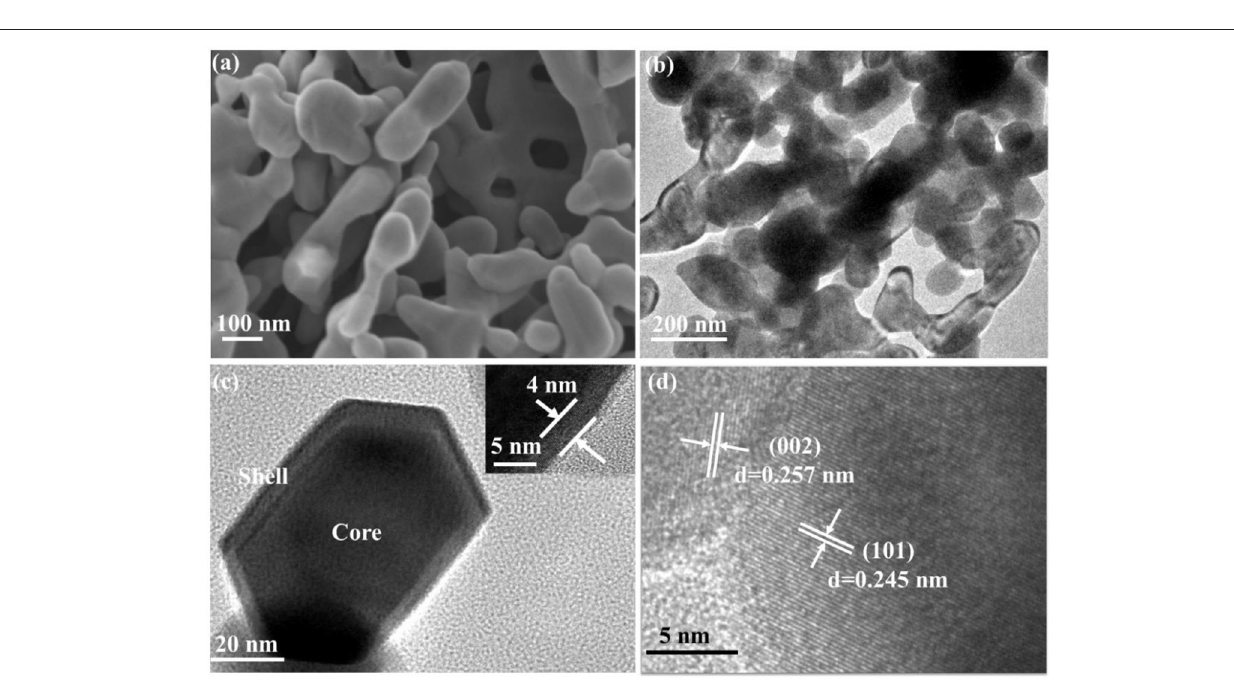
FIGURE 1 | Schematic illustration of the synthesis of porous ZnO photocatalyst.